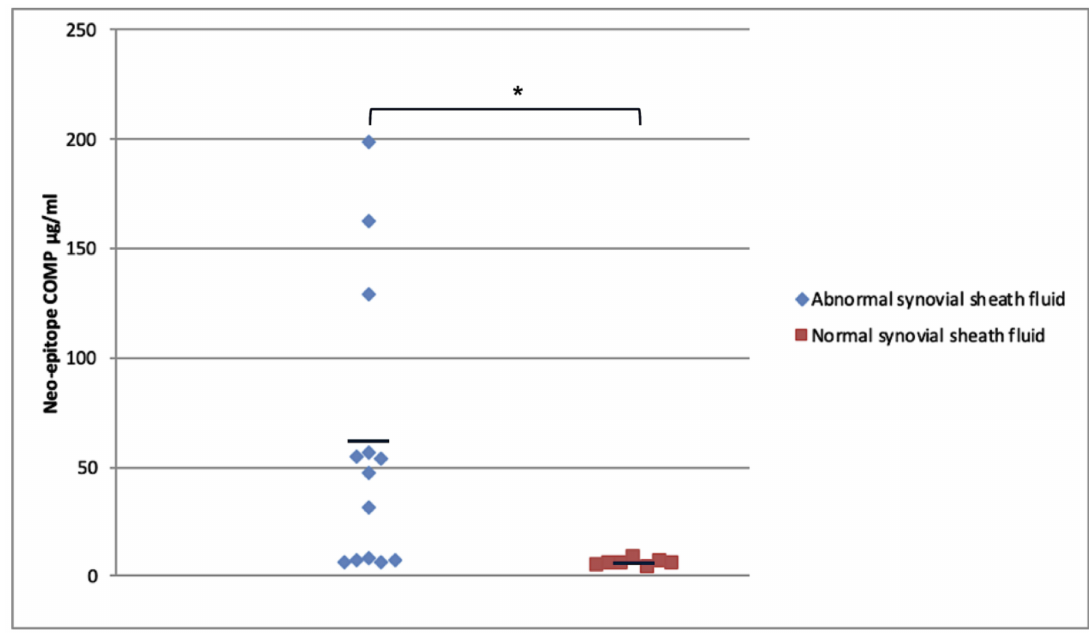
Figure 4. Quantification of the COMP neoepitope in both normal ( n = 7) and abnormal (from cases with intra-thecal tendon injury; n = 13) tendon sheath synovial fluids. The bars show the mean value. * denotes significant di ff erence between the groups; p < 0.002. Note the large variation seen for the abnormal synovial